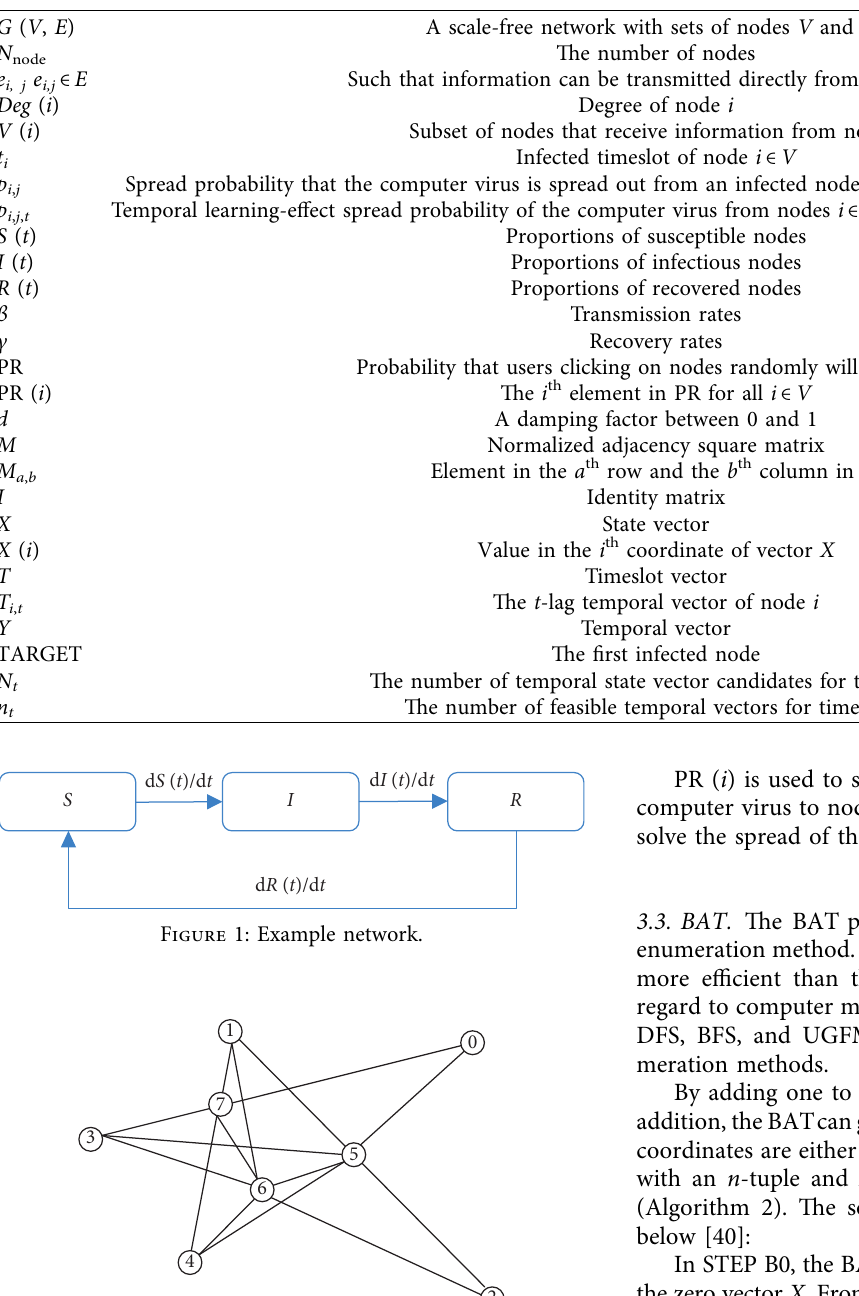
Table 2: Notations.